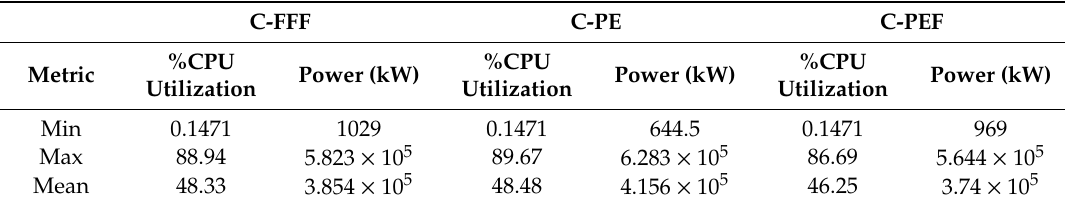
Table 12. Statistical analysis with dynamic